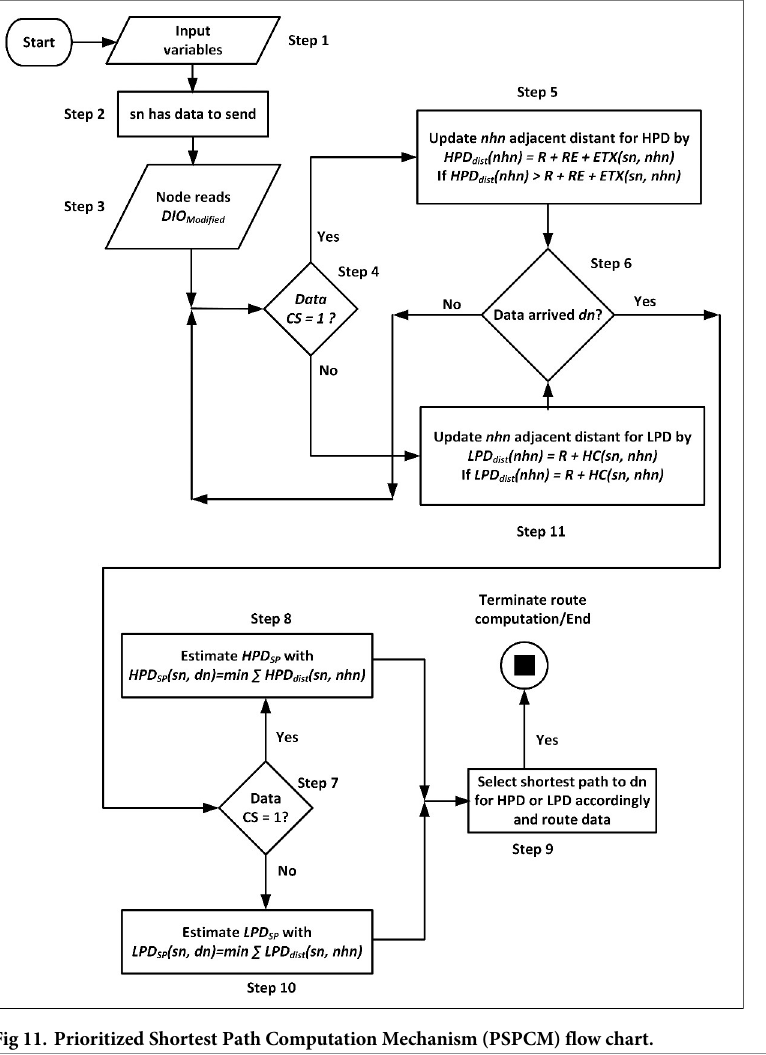
Fig 11. Prioritized Shortest Path Computation Mechanism (PSPCM) flow